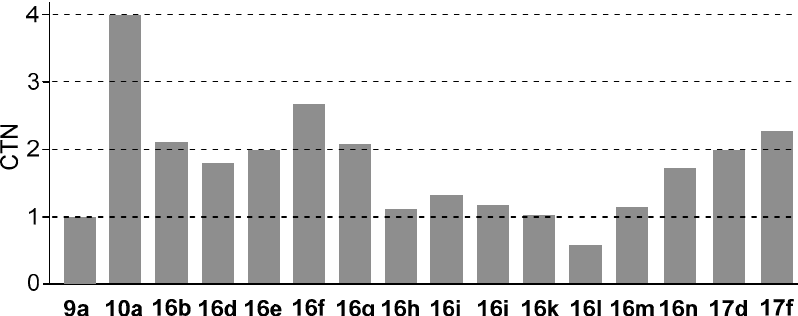
Figure 9. Comparison of catalytic turnover numbers (CTN) of 9a , 10a , 16b , 16d – n , 17d , and 17f at [MNP] = 1000 μ M and [ 9 , 16 , 17 ] = 20 μ M (in the total solution) in CHCl 3 /50 mM HEPES buffer (pH 7.4) with I = 0.1 (NaNO 3 ) (2/8) at 37 °C.